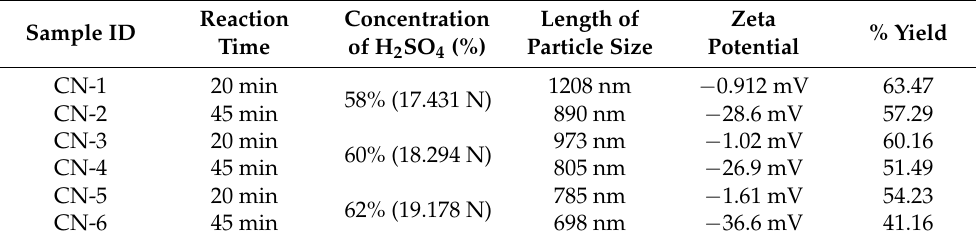
Table 1. The particle size and zeta potential values of different samples of CNCs.